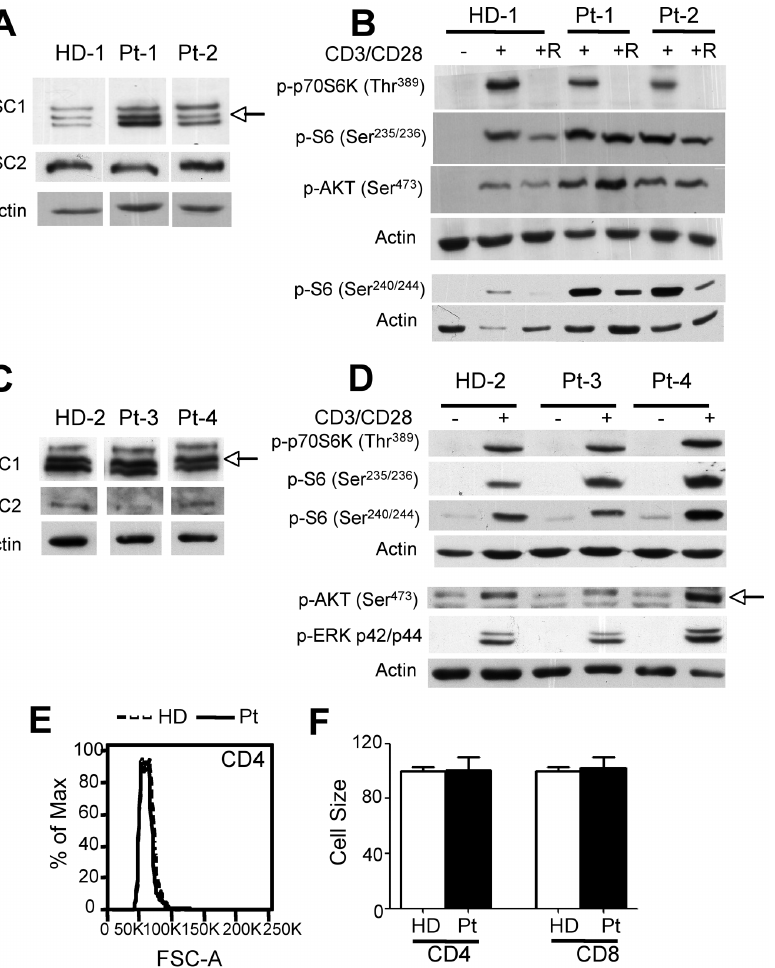
Figure 2. mTOR-dependent signaling is preserved in human T cells with monoallelic germline TSC1 mutations. A–D) Human CD3 + lines derived from healthy donors (HD) and TSC1 subjects (Pt1-4) (see methods) were left untreated (-) or stimulated with anti-CD3 and CD28 mAb for 30 min ( + ). Where indicated cells were pretreated for 30 min with Rapamycin and then stimulated with anti-CD3/CD28 mAb ( + R). Cell extracts were analyzed with the indicated antibody. Arrows indicate the specific bands. E-F) Cell size was determined in fresh PBMC isolated from 8 HD and 4 TSC1 Pts by FACS and is depicted after gating on CD4 + or CD8 + cells. In E a representative overlay is depicted, while data in F represent the average cell size 6 SEM.